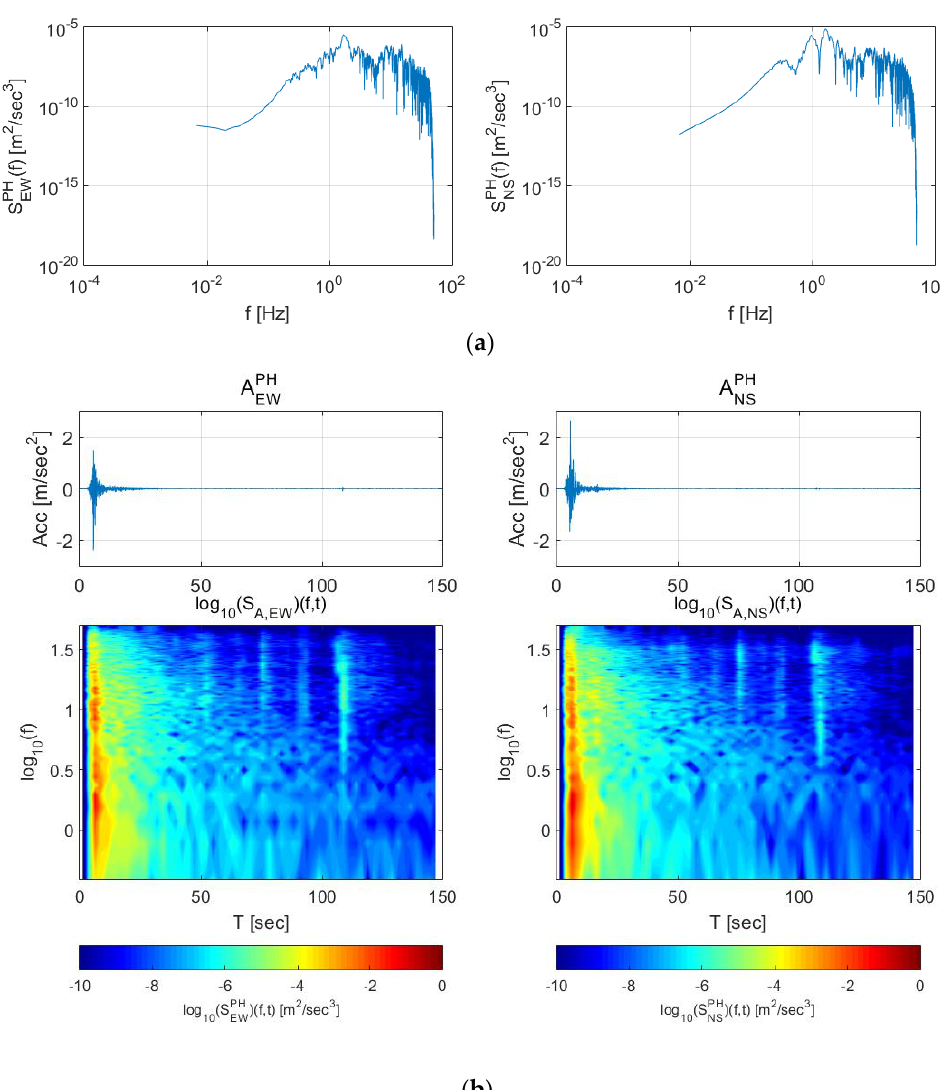
Figure 12. Spectral characteristics of the Pohang earthquake presented as ( a ) Power Spectral Density (PSD) and ( b ) spectrogram.